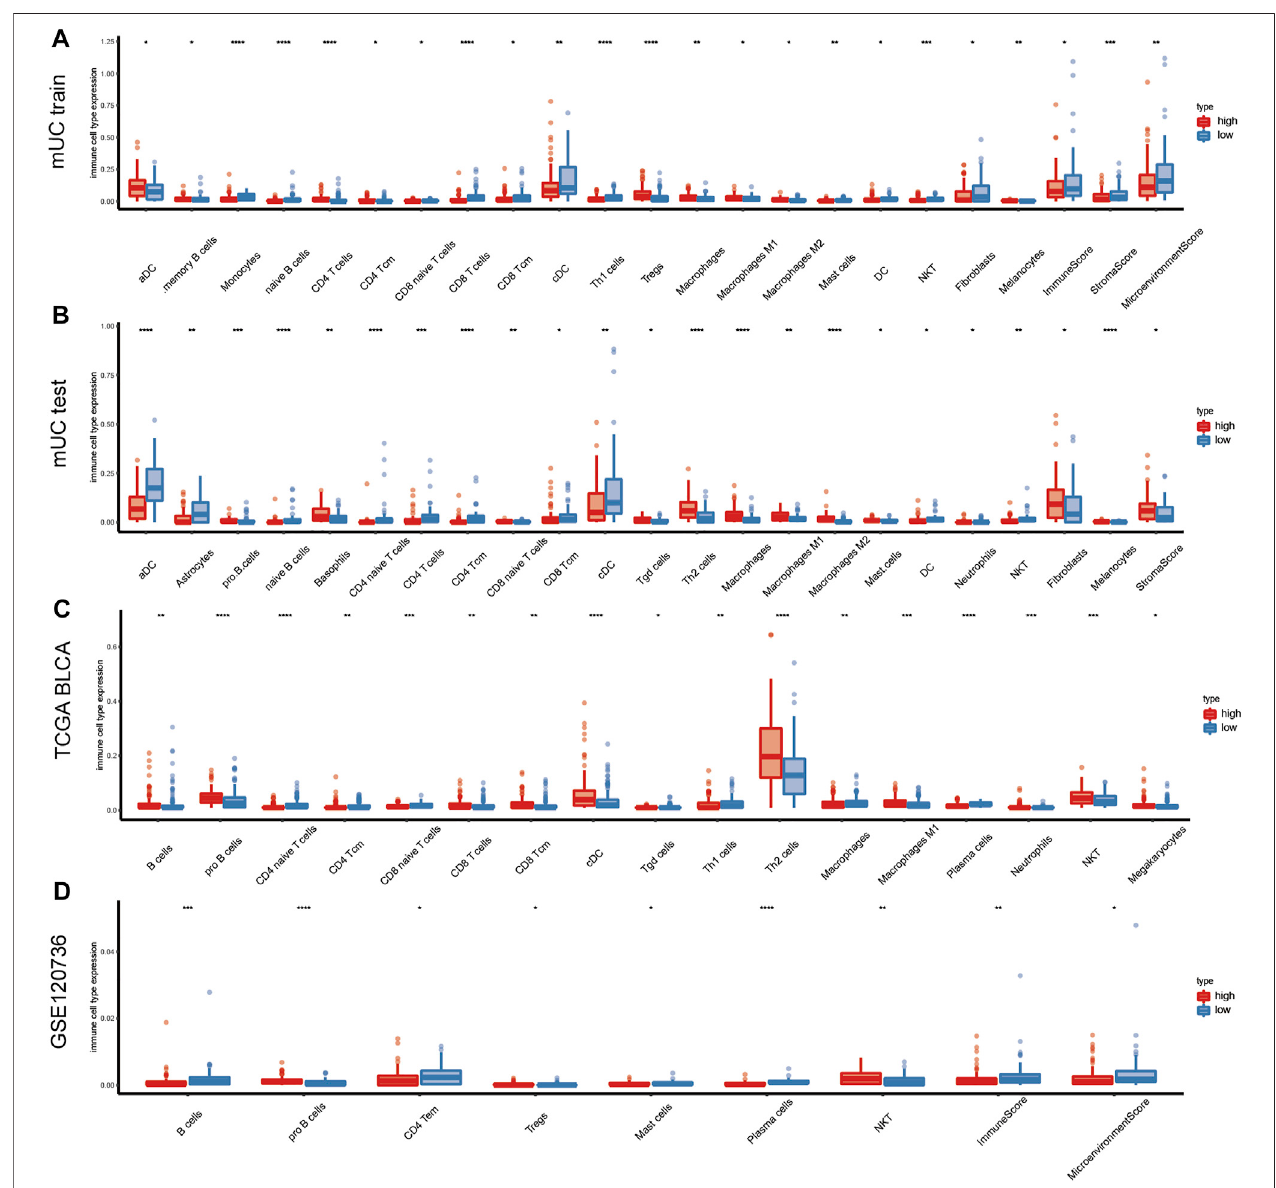
FIGURE 5 | Changes of immune components in tumor hypoxia microenvironment. (A – D) Diagram shows the immune microenvironment in fi ltration score of the training set, testing set, TCGA BLCA and GSE120736 datasets in metastatic urothelial carcinoma. The fi gure shows the immune cells with statistical difference in the analysis results ( p < 0.05), and the results show that T cells, B cells, macrophages, and Treg cells were more in fi ltrated in the high hypoxia risk score subgroup. (CD4 + Tcm: CD4 + central memory T cells, CD8 + Tcm: CD8 + central memory T cells, NKT: natural killer T cells).